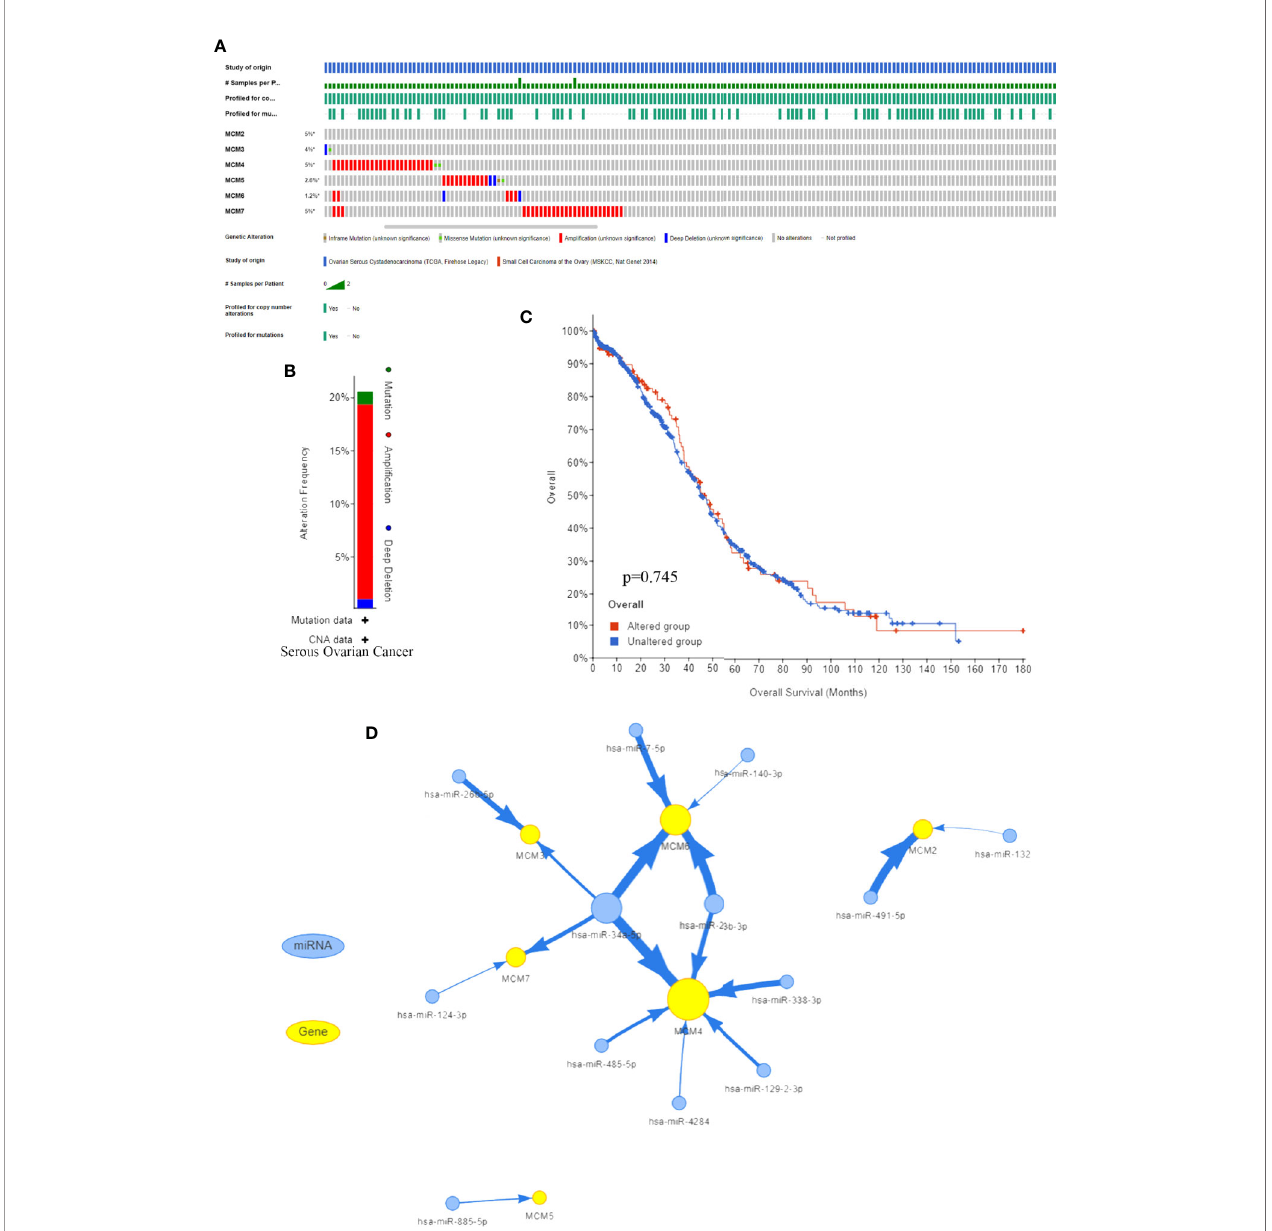
FIGURE 5 | Regulation of the MCMs (A) Frequency of the MCM complex based on the cBioProtal database. (B) MCM gene alterations in serous ovarian cancer. (C) Kaplan – Meier plots of the OS of OC patients with or without MCM alterations. (D) The network among MCMs and